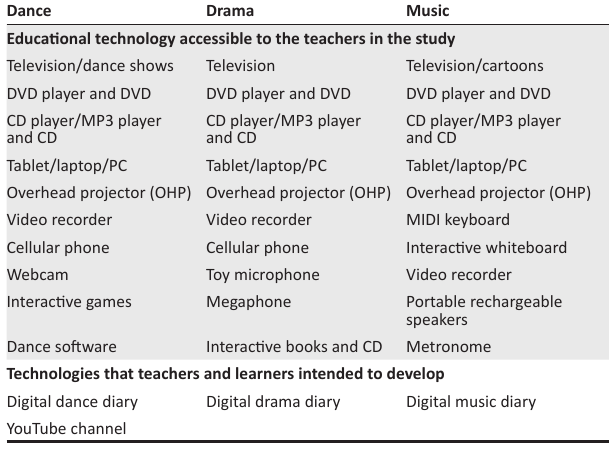
TABLE 1: Educational technology accessible and intended to